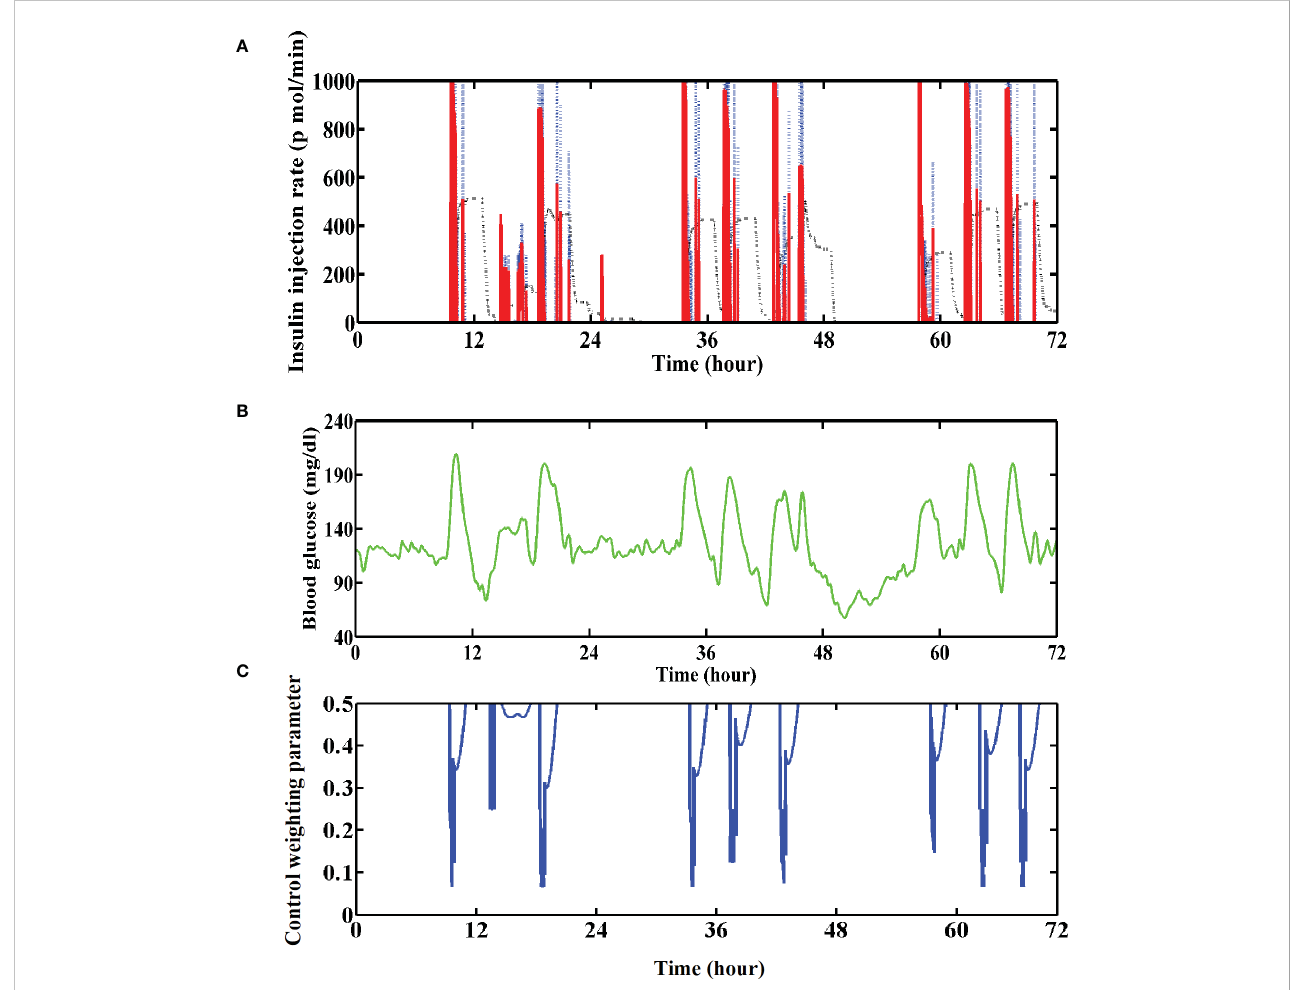
FIGURE 8 (A) Insulin injection rate for the No. 01 subject with the GPC+IOB+AW controller. The blue dotted line denotes the ideal insulin injection rate calculated by the GPC controller, the black dotted line denotes the estimated active insulin amount in the body and the red line denotes their subtraction. (B) Variations of the BG trace of the No. 01 subject with GPC+IOB+AW controller. (C) Variations of the control weighting parameter of the No. 01